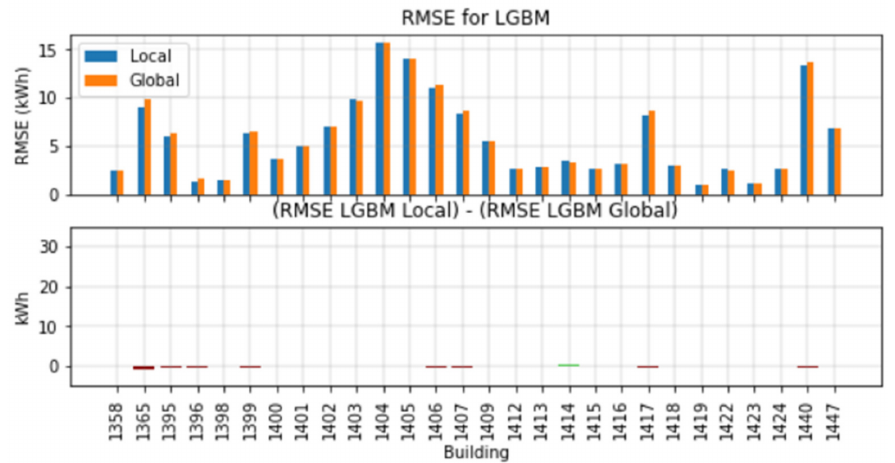
Figure 10. Comparison (in the upper figure) and difference (in the lower figure) between the RMSE obtained from local and global LGBM models on test set.